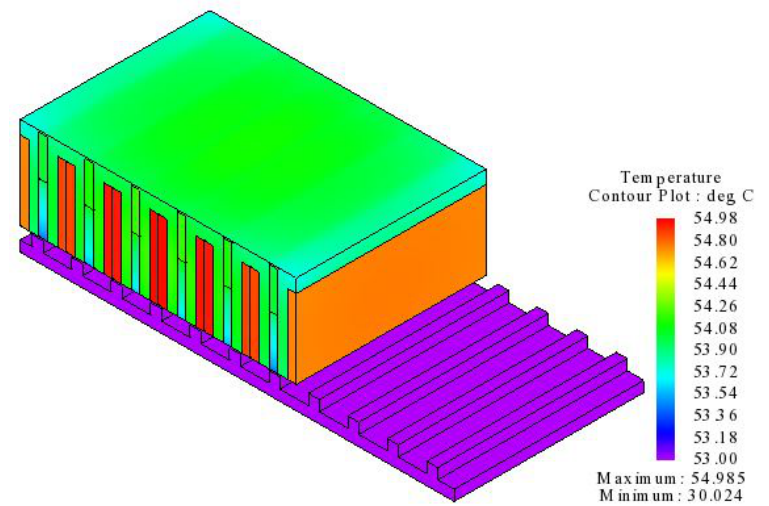
Figure 25. 3D thermal analysis of the proposed machine.